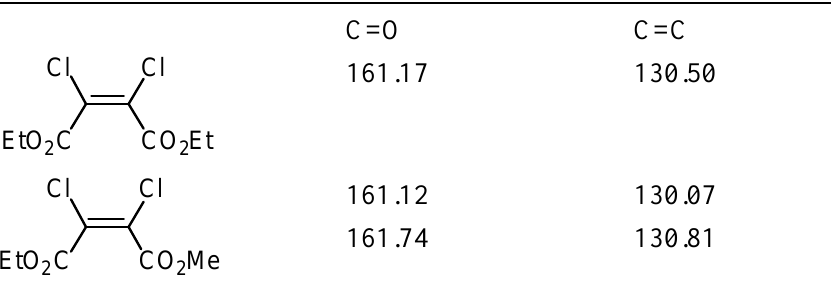
Table 3. 13 C chemical shifts (ppm) of diethyl ( Z )-2,3-dichloro-butenedioate [1] and ethyl methyl ( Z